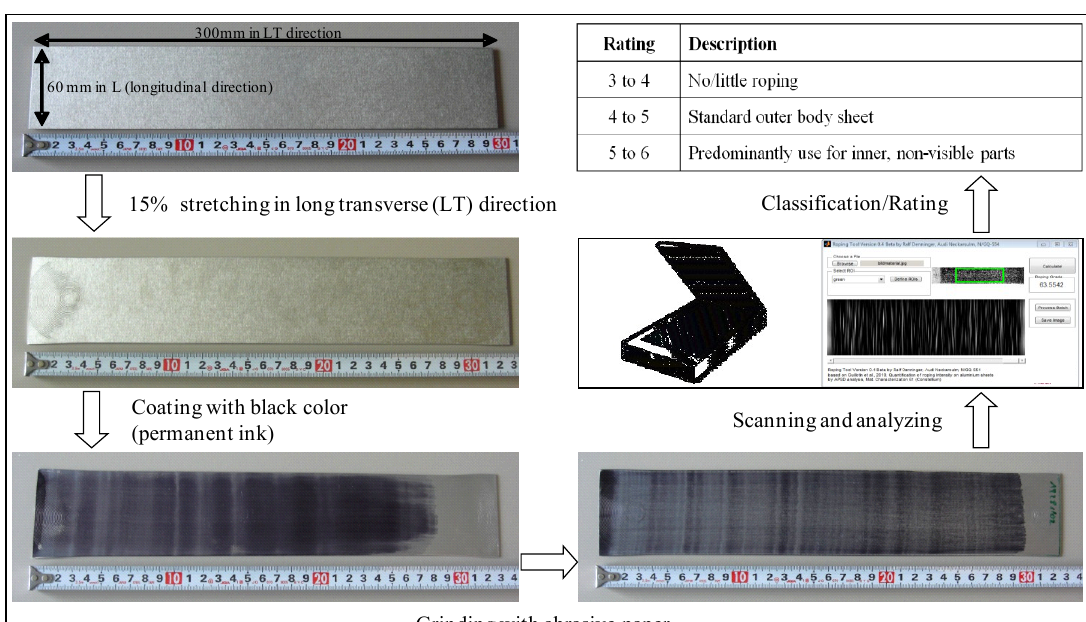
Figure 4. Roping test procedure rating.